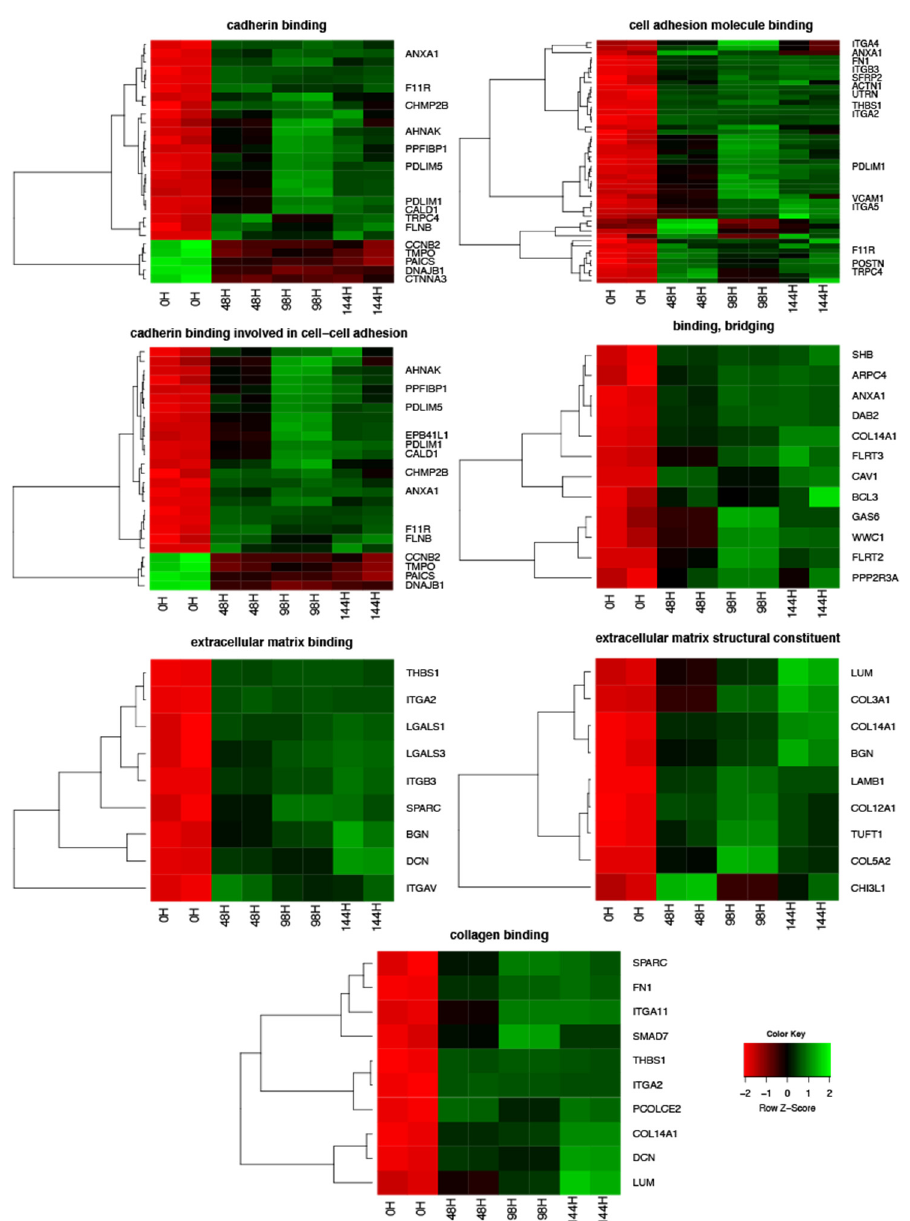
Figure 2. Heatmaps presenting differentially expressed genes involved in “extracellular matrix binding”, “extracellular matrix structural constituent”, “binding, bridging”, “cadherin binding”, “cell adhesion molecule binding”, “collagen binding” and “cadherin binding involved in cell-cell adhesion” based on GO MF terms. Each row on the Y -axis represents a single transcript. The red color indicates downregulated genes while the green indicates upregulated.